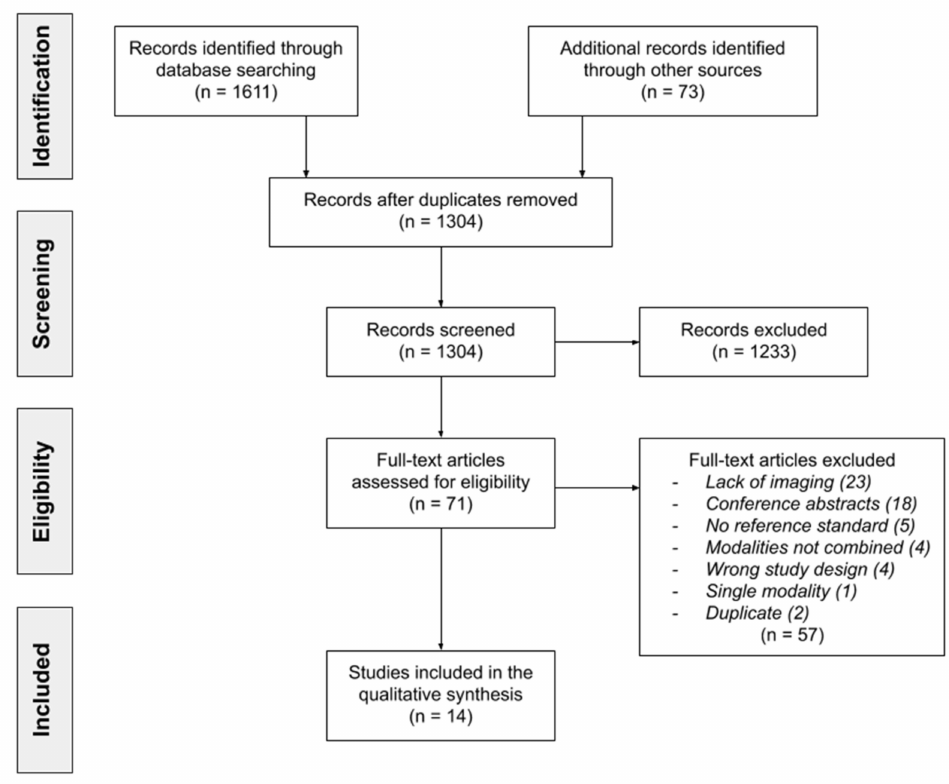
Figure 1. Preferred Reporting Items for Systematic Reviews and Meta-analysis (PRISMA) flowchart of the literature search and study